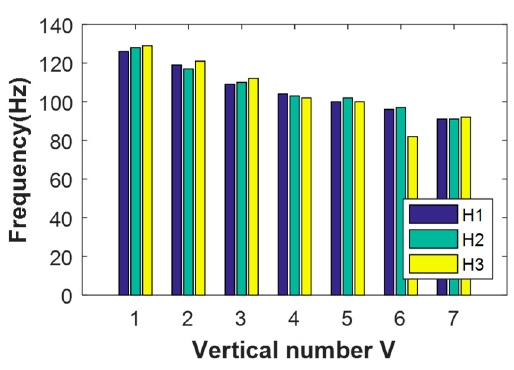
Figure 25. The first natural frequency of the damaged tank with 2.1 kg of added mass.